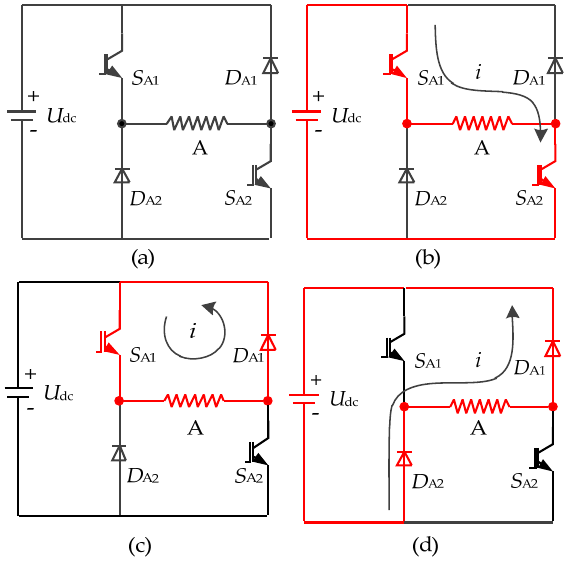
Figure 4. Topology of asymmetric half-bridge inverter. ( a ) Static structure. ( b ) Magnetization. ( c ) Freewheeling. ( d ) Demagnetization.